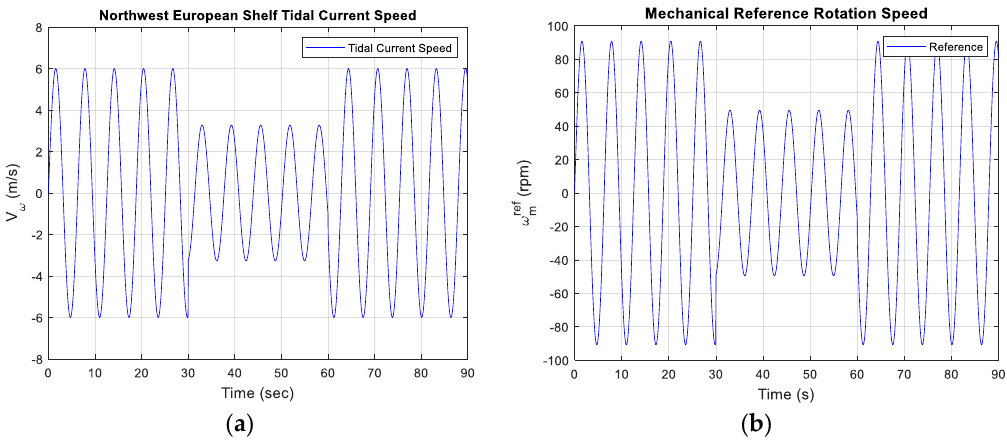
Figure 5. Input and reference signals. ( a ) Northwest European Shelf tidal current speed profile; ( b ) mechanical reference rotation speed by maximum power point tracking